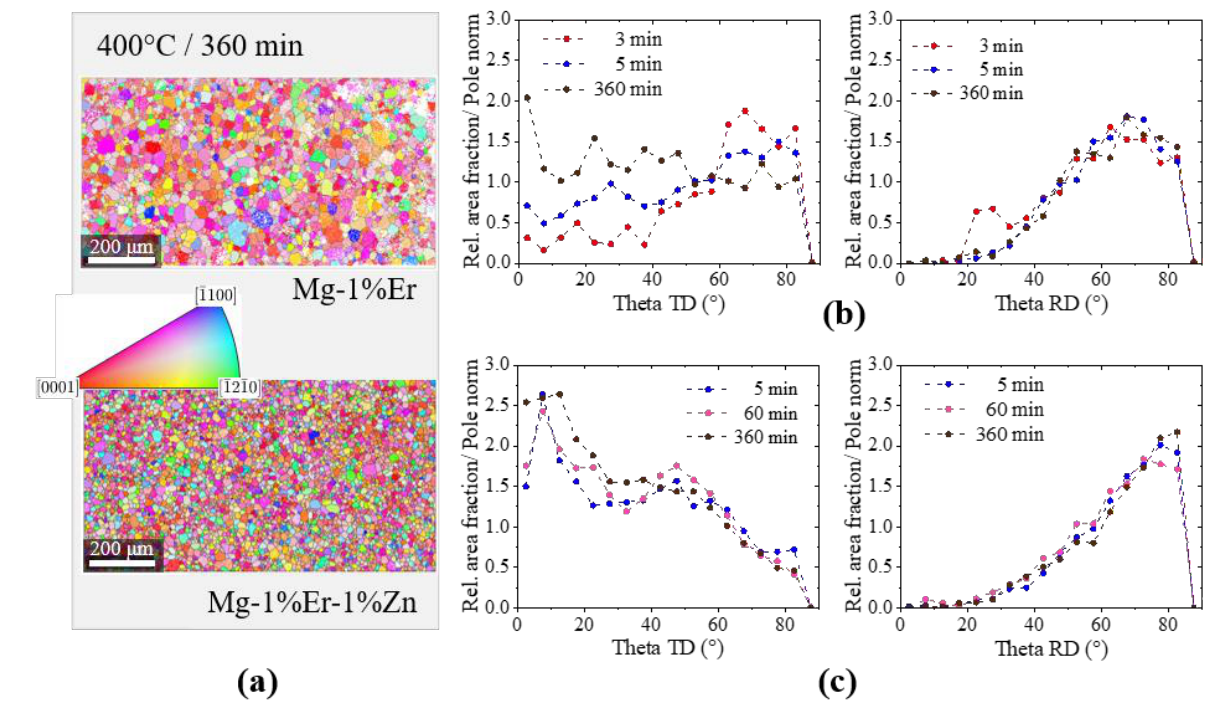
Figure 5. ( a ) EBSD ND-IPF maps of binary (top) and ternary Mg-1%Er-(1%Zn) (bottom) alloys annealed at 400 ◦ C for 360 min; ( b , c ) angle distribution profiles between the c-axis and the transverse and rolling directions for different annealing durations.